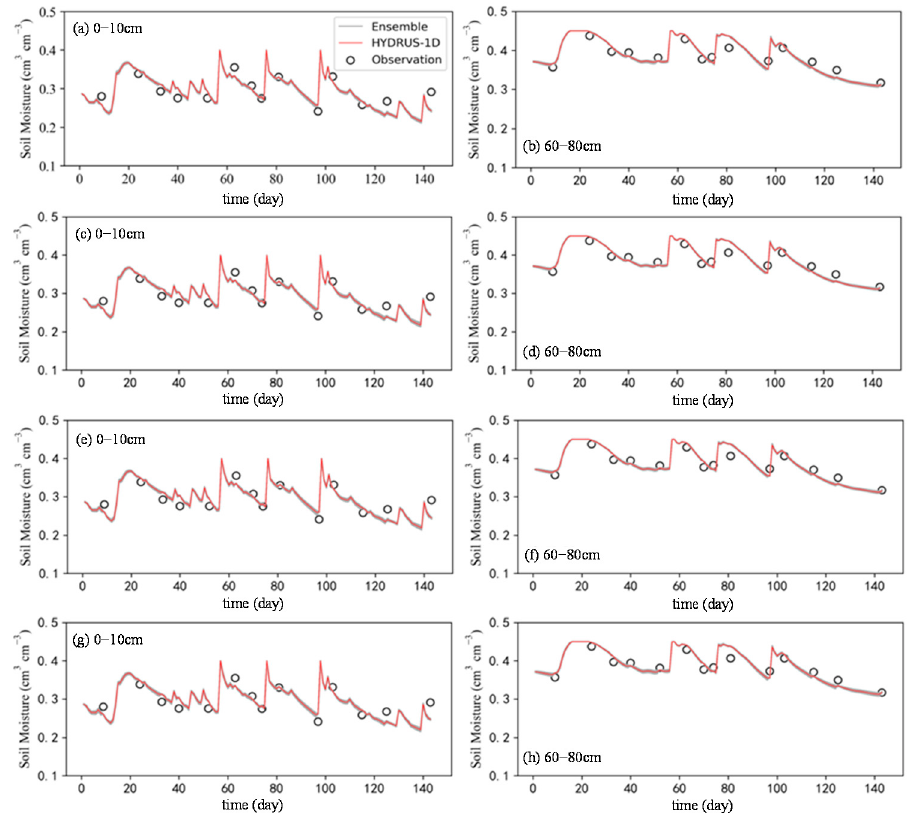
Figure 12. Simulated soil moisture at different depths with different ensemble sizes: ( a ) 0–10 cm, with an ensemble size of 30; ( b ) 60–80 cm, with an ensemble size of 30; ( c ) 0–10 cm, with an ensemble size of 50; ( d ) 60–80 cm, with an ensemble size of 50; ( e ) 0–10 cm, with an ensemble size of 100; ( f ) 60–80 cm, with an ensemble size of 100; ( g ) 0–10 cm, with an ensemble size of 200; ( h ) 60–80 cm, with an ensemble size of